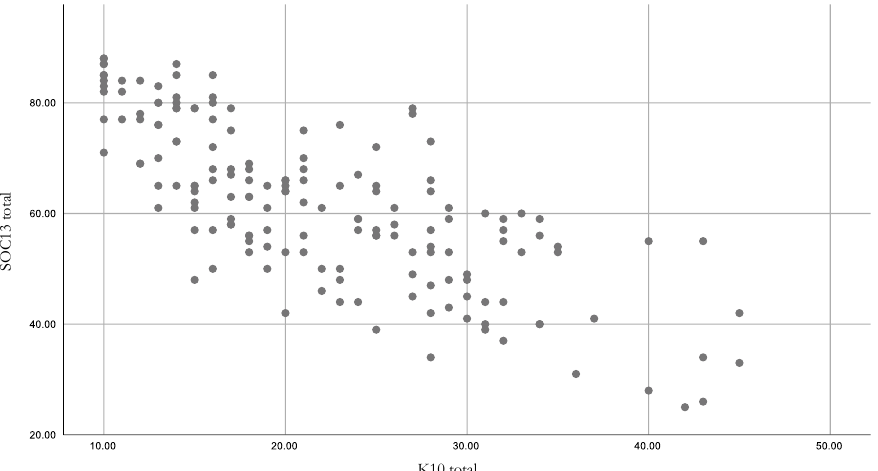
Figure 5. Scatter plot showing correlation between SOC13 and K10 (N.B. SOC13 strength: weak 13–63; and strong 64–91). Table 6. Univariate analysis of sociodemographics with SOC13 and K10. SOC13 b K10 Sociodemographics